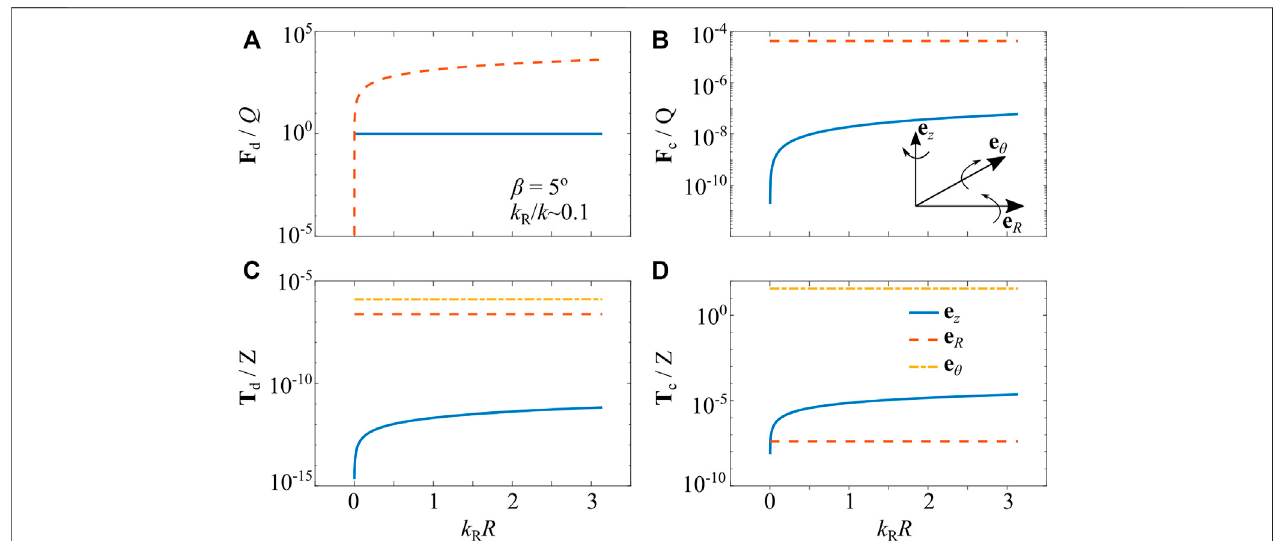
FIGURE 2 | Partial forces, panels (A),(B) , and torques, panels (C),(D) , due to direct and Willis coupling acoustic polarization for a weak Bessel beam of β = 5 ° and k R / K ≈ 0.1,withrespecttotheradialdistancefromthebeamaxisat R =0fortheasymmetricobjectgivenbyitspolarizabilitycoef fi cientsin Eq.31 .Thecomponentsofthe forces and torques in the cylindrical coordinate system ( e R , e θ , e z ) are shown by different line types. For the forces in panel (A),(B) , the θ -component is zero. The magnitude of these forces are shown in the logarithmic scale to indicate the difference in orders of magnitude.